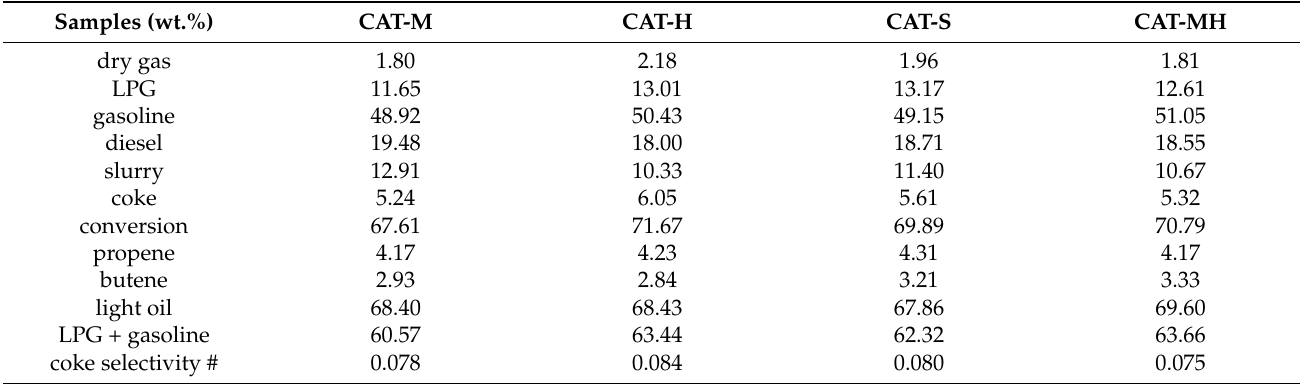
Table 7. Evaluation results of the fixed-fluidized bed.